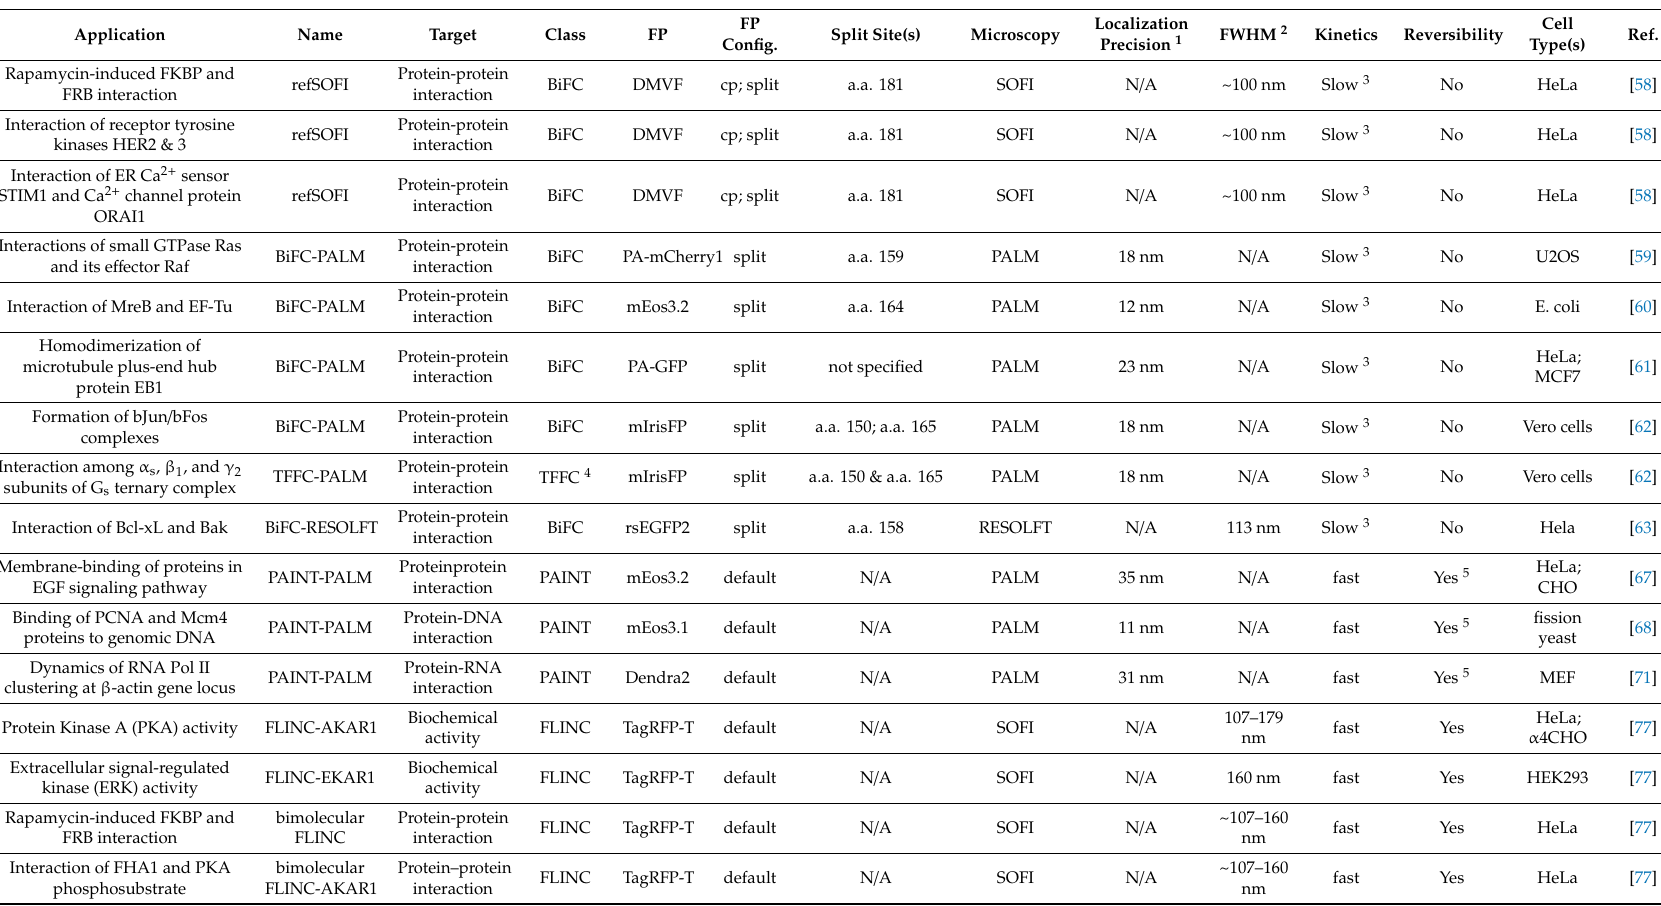
Table 1. Reported functional SRM studies of biomolecule interactions and biochemical activities in living cells with genetically encoded